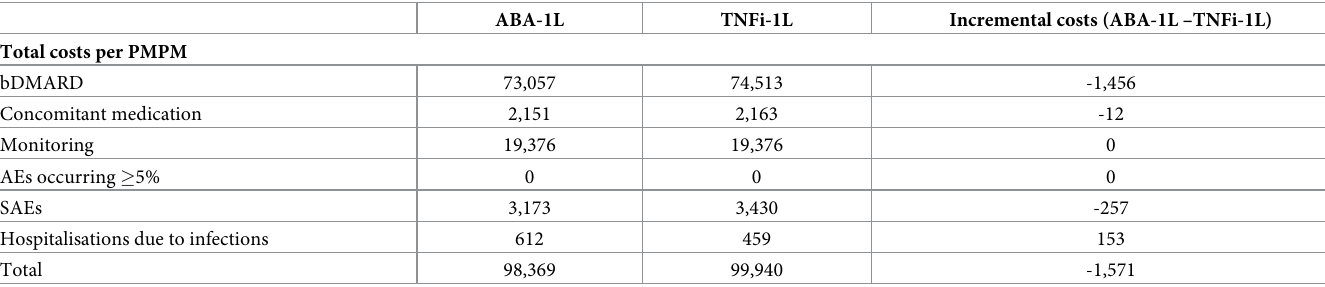
Table 4. Cost results breakdown–per patient per month (ABA-1L vs.